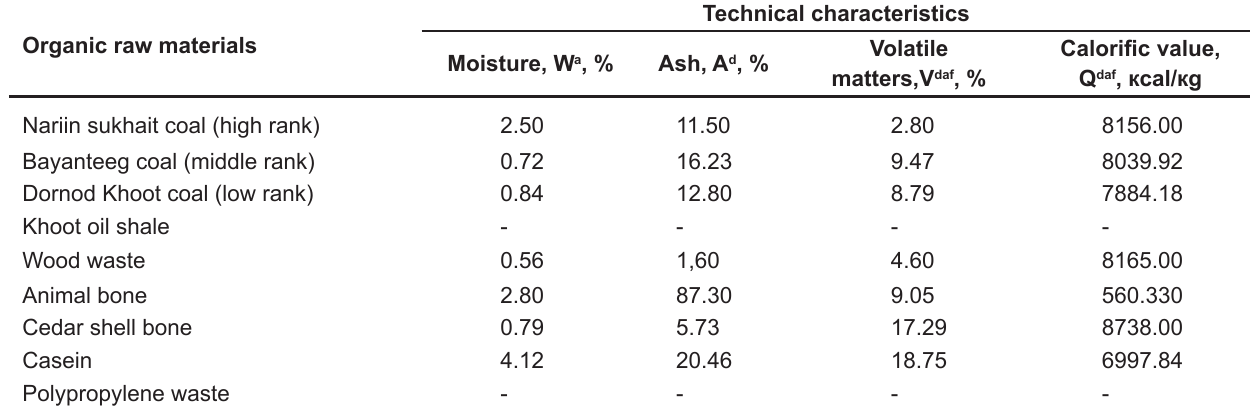
Technical characteristics